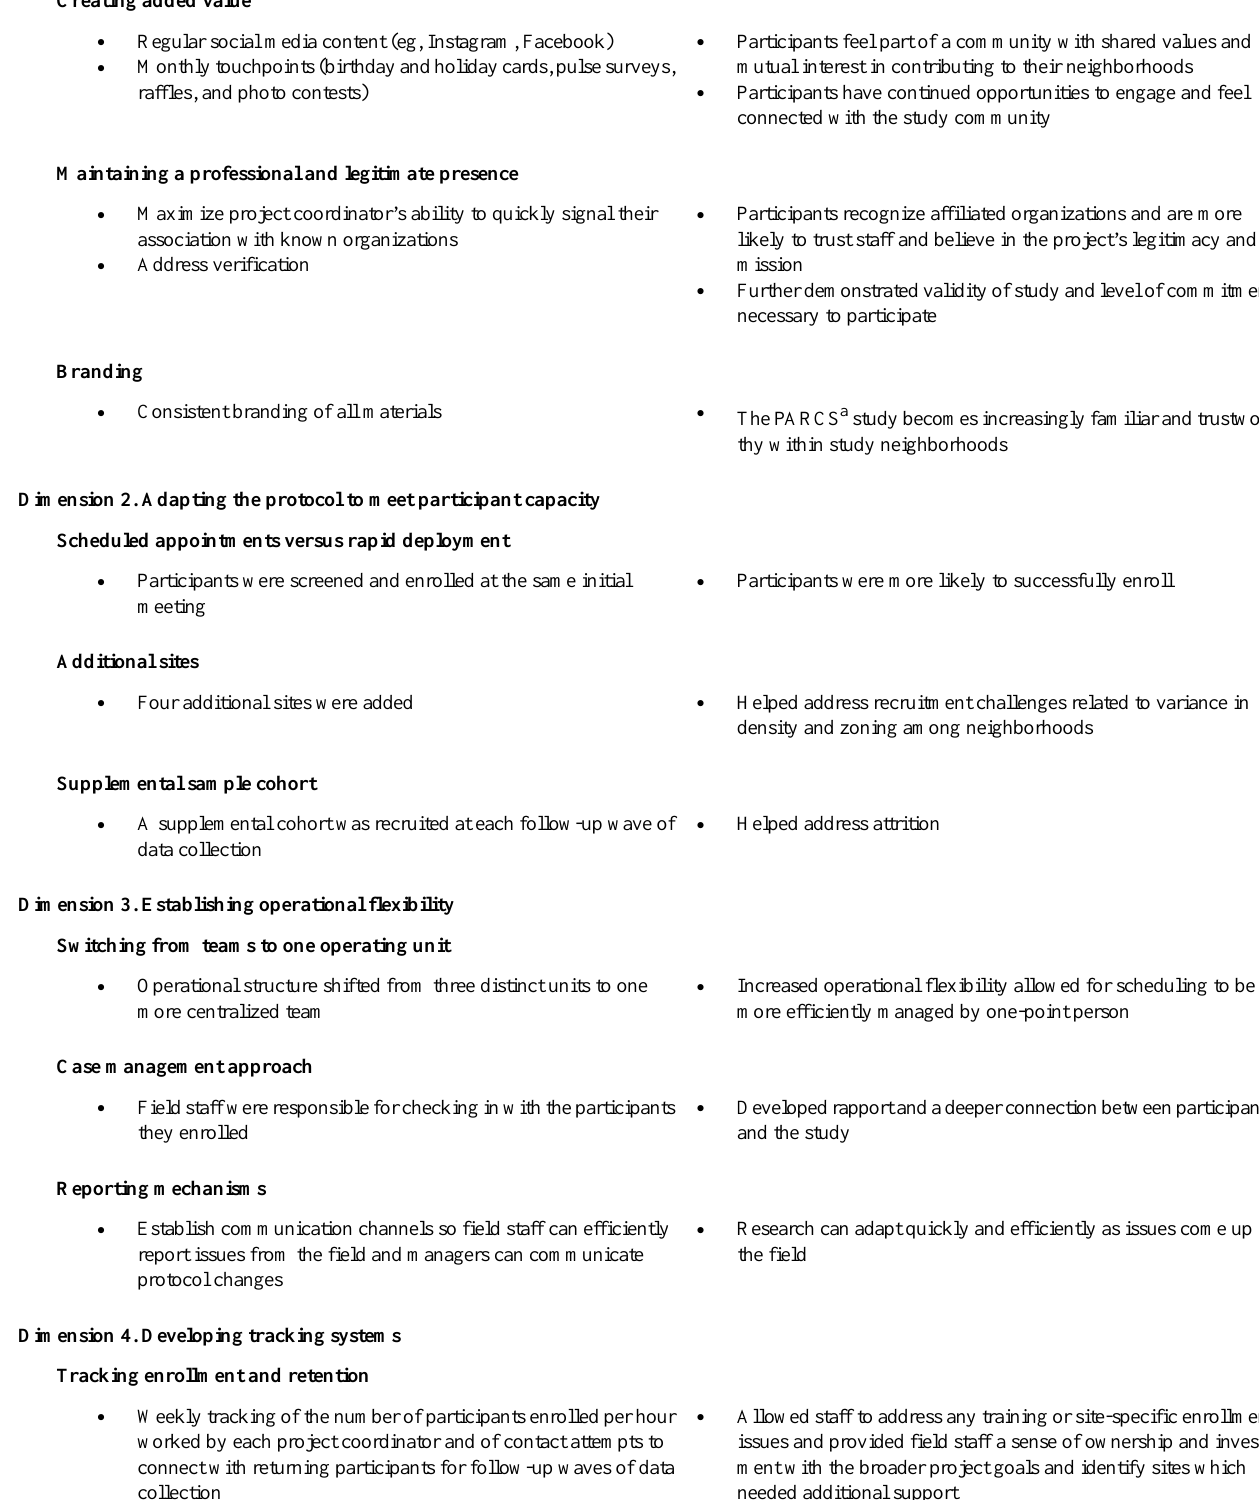
Table 1. Summary of participant engagement strategies. Dimension 1: building trust with